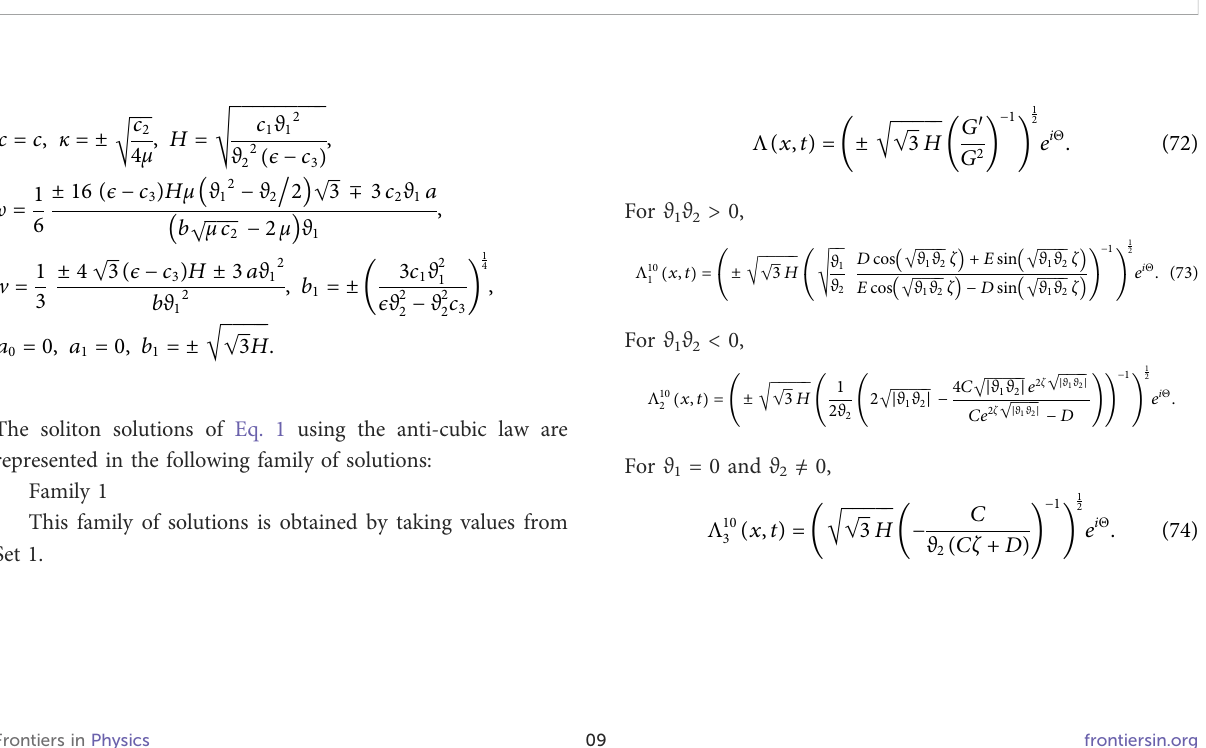
FIGURE 1 Graphical representations of || Λ 1 2 ( x , t )(cid:7) 2 for c =2.1, μ =2.1, and the remaining arbitrary constants are assigned the value of